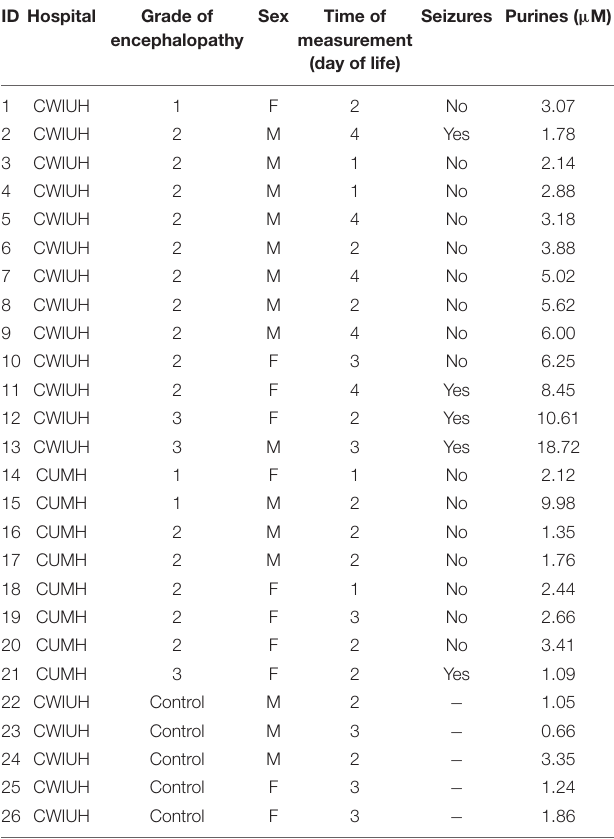
TABLE 1 | Clinical details of infants with corresponding blood purine concentrations. ID Hospital Grade of Sex Time of Seizures Purines ( µ encephalopathy measurement (day of life)